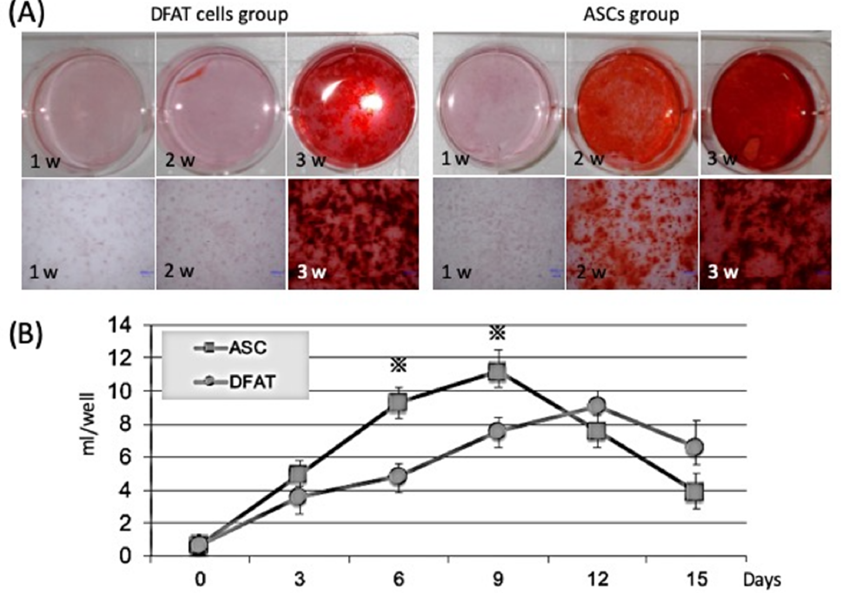
Figure 3. Comparison of osteogenic differentiation capacities by alizarin red staining and ALP activity of DFAT cells and ASCs. ( A ) Mineral depositions of DFAT cells and ASCs were detected by alizarin red staining following 1, 2, and 3 weeks of osteogenic induction. Red areas stained by alizarin red indicate calcium deposition. The well containing DFAT cells cultured in osteogenic medium for 3 weeks and ASCs cultured in osteogenic medium for 2 or 3 weeks were stained by alizarin red, whereas those containing ASCs cultured in osteogenic medium were stained strongly by alizarin red. ( B ) The ALP level of ASCs increased earlier than that of DFAT cells and was significantly different ( p < 0.05) on days 6 and 9. The ALP level of DFATs was higher than that of ASCs after day 12.